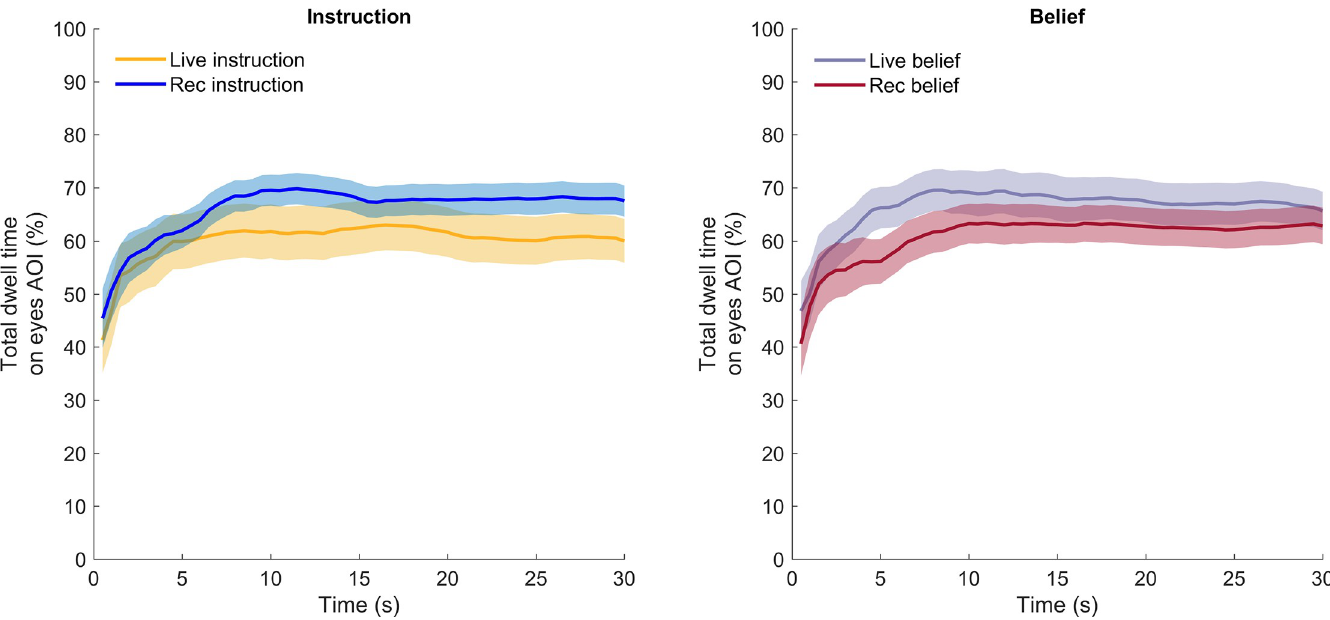
Fig 8. Relative total dwell time on the eyes AOI over time as a function of instruction-type (left panel) and participants’ beliefs (right panel). Lines depict average relative total dwell time (%) over time (in seconds). Shaded regions represent the standard error of the mean. The relative total dwell time on the eyes AOI is consistently lower for the live-instruction group compared with the pre-recorded instruction group. Conversely, the relative total dwell time on the eyes AOI is consistently higher for the live-belief group compared with the pre-recorded belief group.